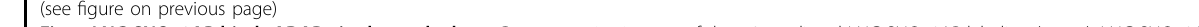
Fig. 4 LNC-SNO49AB binds ADAR1 in the nucleolus. a Representative images of dcas13-mediated LNC-SNO49AB labeling (green); LNC-SNO49AB colocalized with FBL (red) in NB4 cells. Scale bars, 2 μ m. b Subcellular localization of LNC-SNO49AB in MV4-11 and NB4 cells. MALAT1, SNORD49A and GAPDH RNAs were used as controls for nucleolar, nuclear, and cytoplasmic fractions, respectively. c Silver staining of proteins pulled down by in vitro transcribed tRSA and tRSA-LNC-SNO49AB from total protein extracts of MOLM13 cells. Red arrow shows the speci fi c band. d ADAR1 was pulled down by tRSA-LNC-SNO49AB but not tRSA in MOLM13, MV4-11 and RS4;11 cells, as determined by western blotting. e In vitro RNA pull-down assay with puri fi ed recombinant Flag-ADAR1 and tRSA-LNC-SNO49AB. Representative results are shown from three replicates. f Representative images of dcas13-mediated LNC-SNO49AB labeling (green); LNC-SNO49AB colocalized with ADAR1 (red) in NB4 cells. Scale bars, 2 μ m. g Schematic representation of the ADAR1 deletion mutants used in the RNA pull-down and RIP assays shown in h and i . h Western blot of the indicated Flag- tagged ADAR1 deletion mutants retrieved by in vitro transcribed tRSA-LNC-SNO49AB obtained from 293T cell extracts. *Represented the non-speci fi c band. Representative results are shown from three replicates. i qRT-PCR analysis of endogenous LNC-SNO49AB enriched by the indicated Flag-tagged ADAR1 deletion mutants in 293T cells. GAPDH mRNA served as the negative control. Representative results are shown from three replicates. j Schematic representation of the ADAR1 deletion mutants used in the RNA pull-down and RIP assays shown in k – m . k qRT-PCR analysis of endogenous LNC-SNO49AB enriched by the indicated Flag-tagged ADAR1 deletion mutants in 293T cells. GAPDH served as the negative control. Representative results are shown from three replicates. l qRT-PCR analysis of endogenous LNC-SNO49AB enriched by the indicated Flag-tagged ADAR1 deletion mutants in 293T cells. PTPN6, CALM1 and APH1B are the representative targets of ADAR1. Representative results are shown from three replicates. m Western blot of the indicated Flag-tagged ADAR1 deletion mutants retrieved by in vitro transcribed tRSA-LNC-SNO49AB obtained from 293T cell extracts. Representative results are shown from three